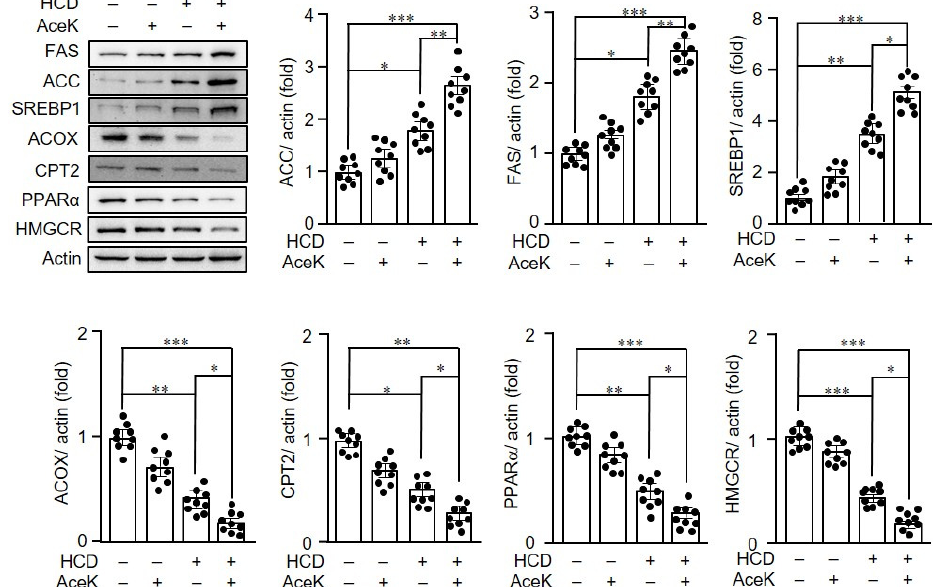
Figure 4. AceK dysregulated lipid homeostasis in ApoE − / − mice. The protein expressions in the liver of ApoE − / − mice of acetyl-coA carboxylase (ACC), fatty acid synthase (FAS), sterol regulatory element binding protein-1 (SREBP1), peroxisomal acyl-coenzyme A oxidase (ACOX), carnitine palmitoyltransferase-2 (CPT2), peroxisome proliferator-activated receptor α (PPAR α ) and 3-hydroxy-3-methyl-glutaryl-coenzyme A reductase (HMGCR) were determined by Western blots ( n = 9 per group of mice). * p < 0.05, ** p < 0.01, *** p < 0.001.